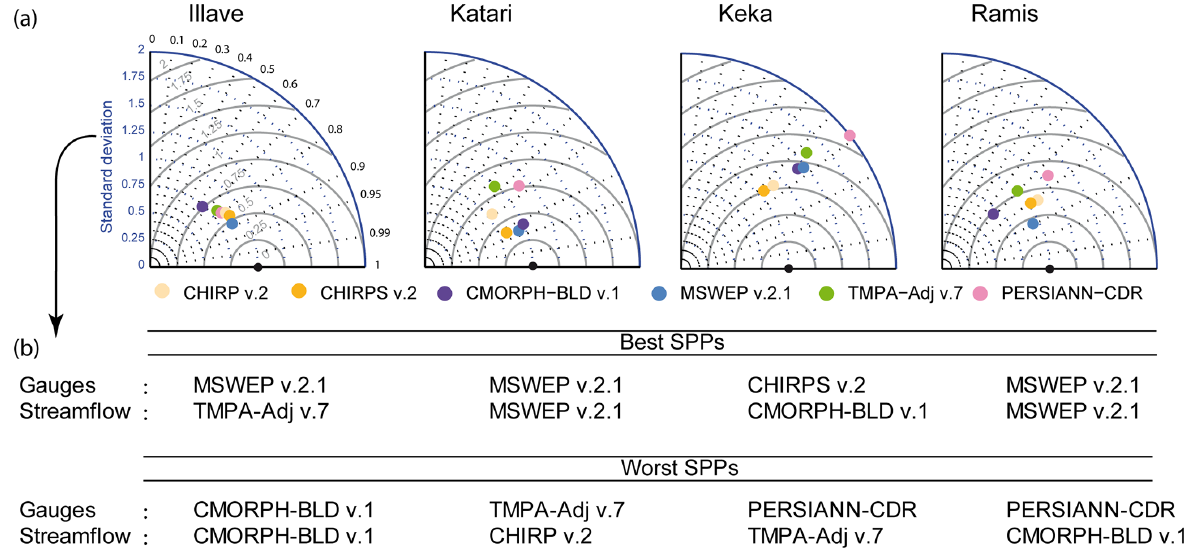
Figure 10. Comparison of the performance of the SPPs with that of precipitation gauges and observed streamflow at the outlet of the four basins (Ilave, Katari, Keka, and Ramis): (a) SPP performance at the gauge level for the four catchments represented according to a Taylor diagram (scores were computed using only the grid cells included in the catchments for the 2008–2012 period); (b) best and worst SPPs according to the gauge-based and hydrological-based assessments for the 2008–2012